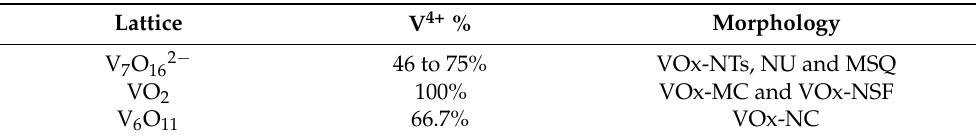
Table 2. Reduction percentage of V 4+ from V 5+ associated with each morphology and structural lattice. Lattice V 4+ % Morphology V 7 O 162